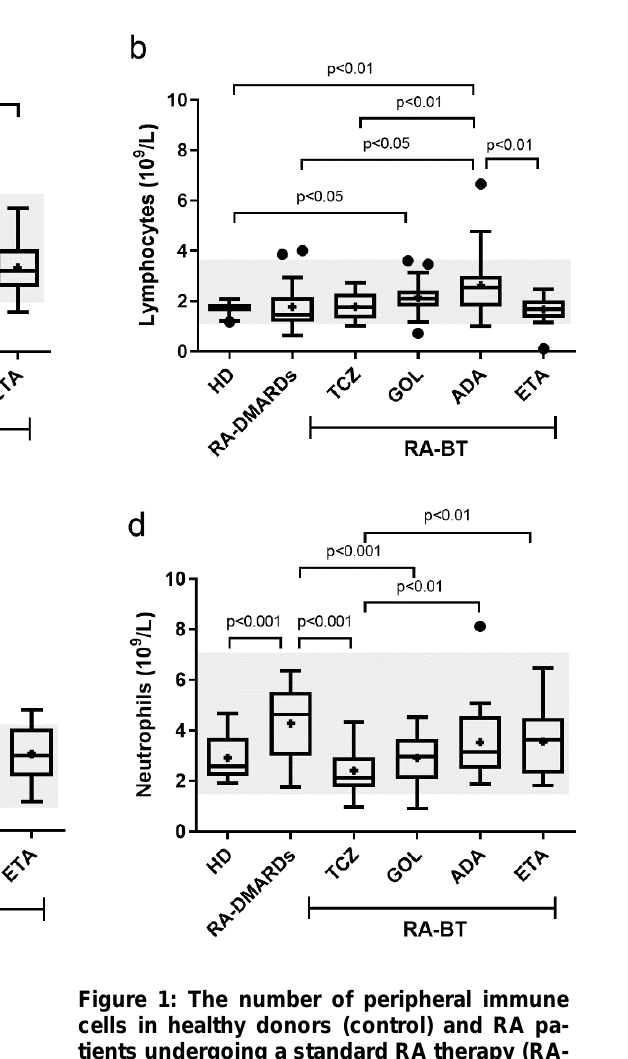
Figure 1: The number of peripheral